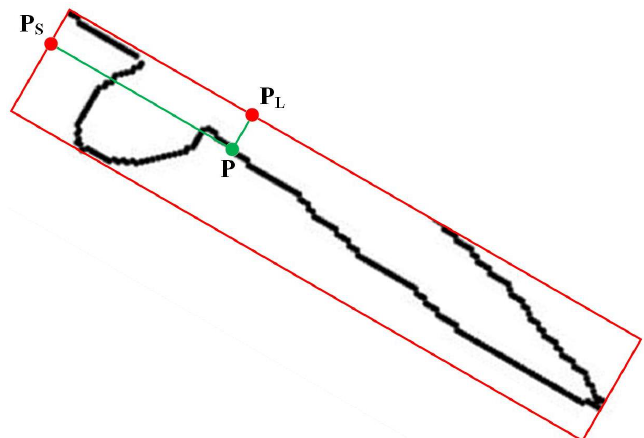
Figure 6. The picture shows the minimum distance of contour point with respect to the MBR. According to this rule, the minimum distance set of all points on the contour can be obtained, and finally the distance richness of the contour can be obtained. Where, the red box denotes the MBR of the contour, and the green line segments denote the distance between a point on the contour and two rectangular sides.